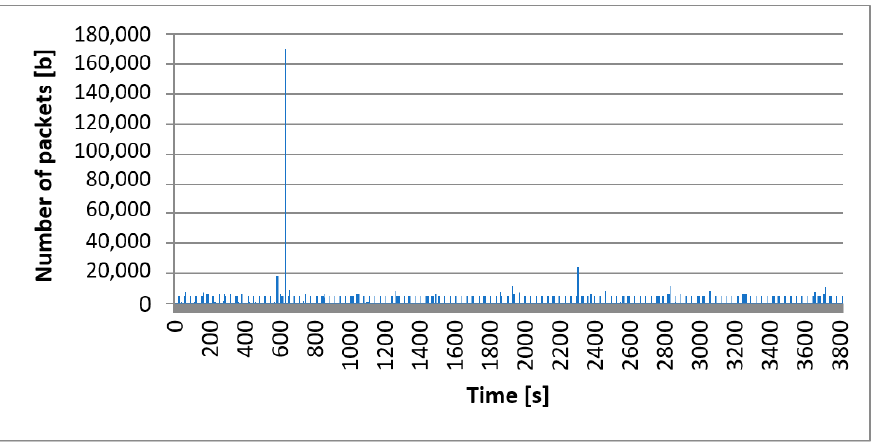
Figure 9. Overall network traffic for low traffic.